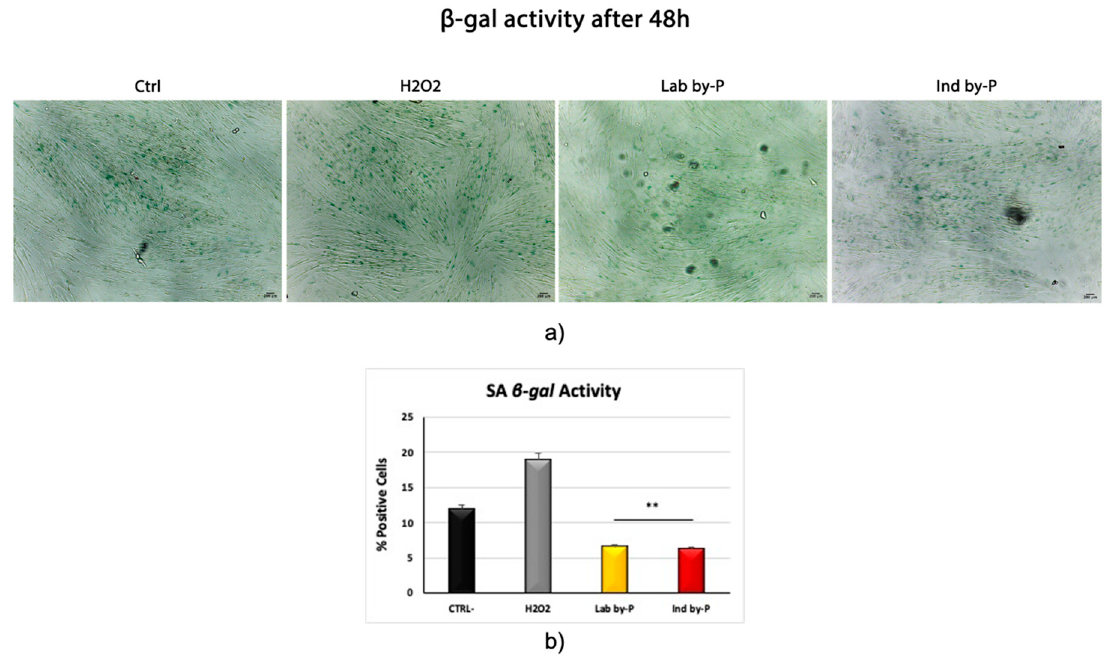
Figure 3. Senescence-associated β -galactosidase activity. ( a ) β -galactosidase was evaluated in H 2 O 2 -senescent ADSCs treated with Lab by-P, or with Ind by-P, compared to control untreated ADSCs (Ctrl). Scale bar = 100 µ m. ( b ) The numbers of positive (blue) and negative cells were counted under the light microscope and the percentage of SA- β -Gal-positive cells for each treatment was calculated as the number of positive cells divided by the total number of cells counted using an image software analysis (ImageJ). Data are expressed as mean ± SD referring to the control (* p ≤ 0.05; ** p ≤ 0.01).